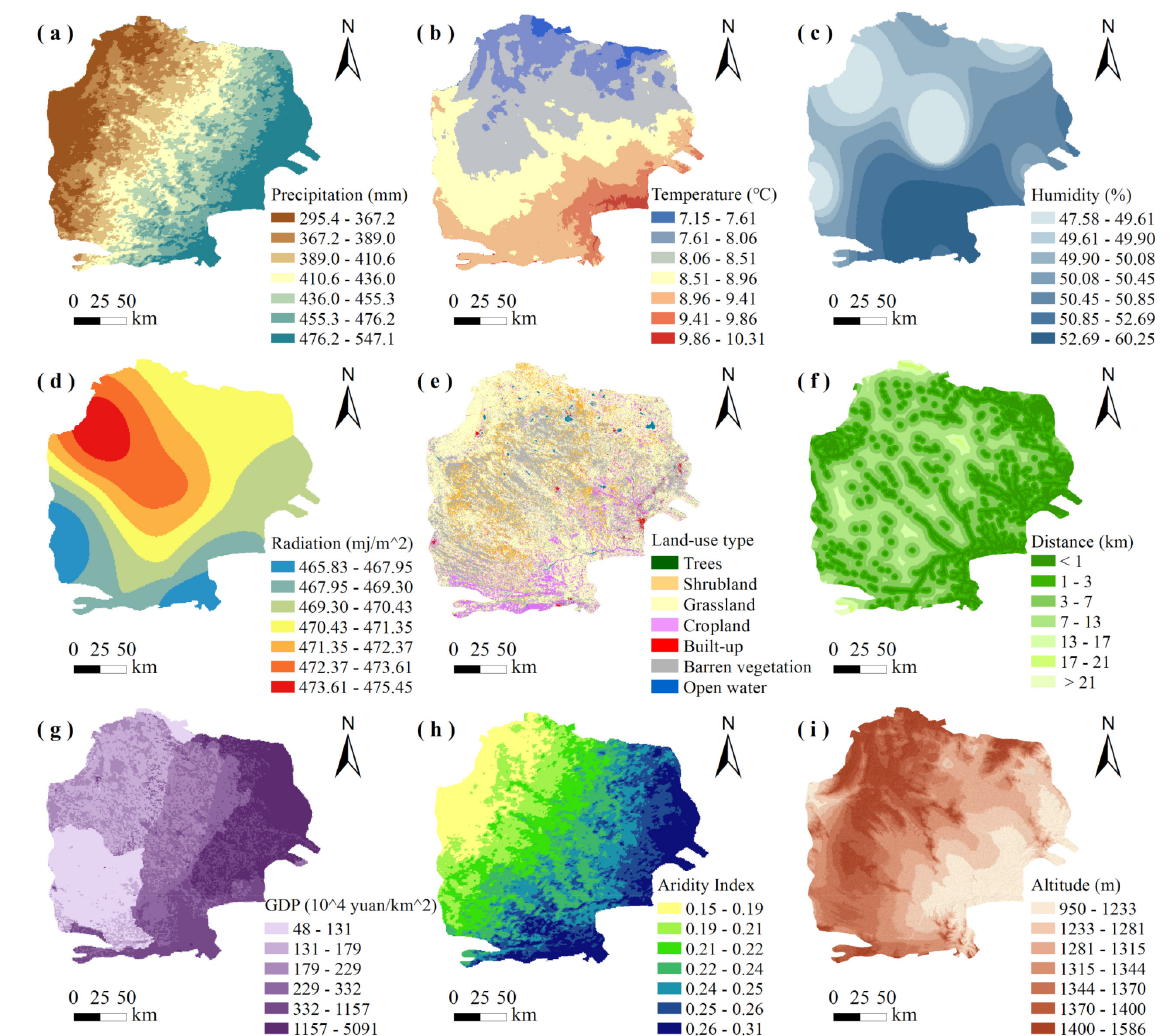
Figure 7. Potential drivers of vegetation coverage (( a ) Annual rainfall. ( b ) Annual mean temperature. ( c ) Annual average humidity. ( d ) Annual average solar radiation intensity. ( e ) Types of land use and land cover. ( f ) River buffer distance. ( g ) GDP of the kilometre grid. ( h ) Aridity index. ( i )